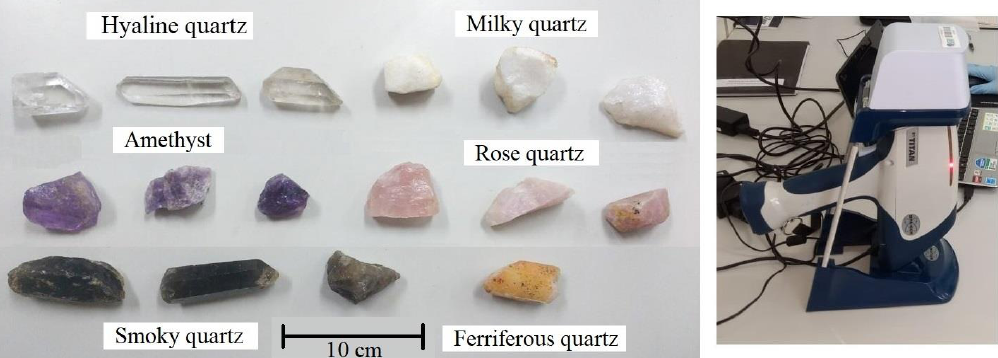
Figure 1. Quartz samples from the Minerals and Rocks Collection of the Federal University of Lavras (UFLA) and the portable X-ray fluorescence spectrometer (on the right) used to analyze the samples in this study.